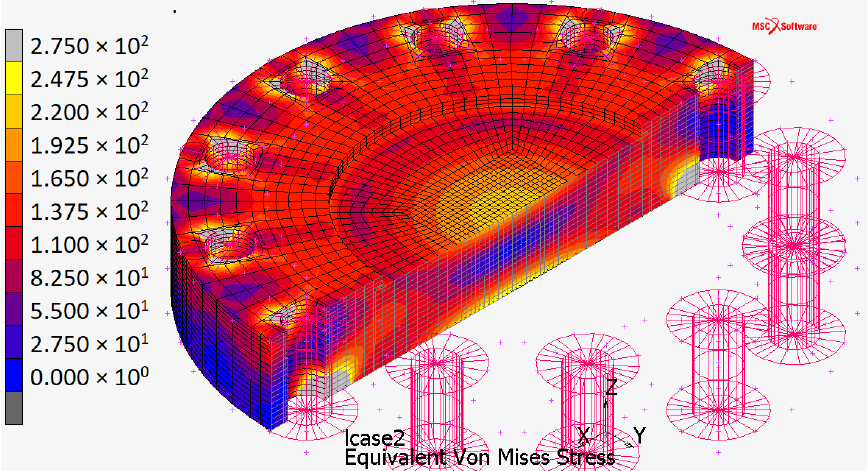
Figure 8. Von Mises stress distribution for the plate when constrained by touching contact with infinitely rigid